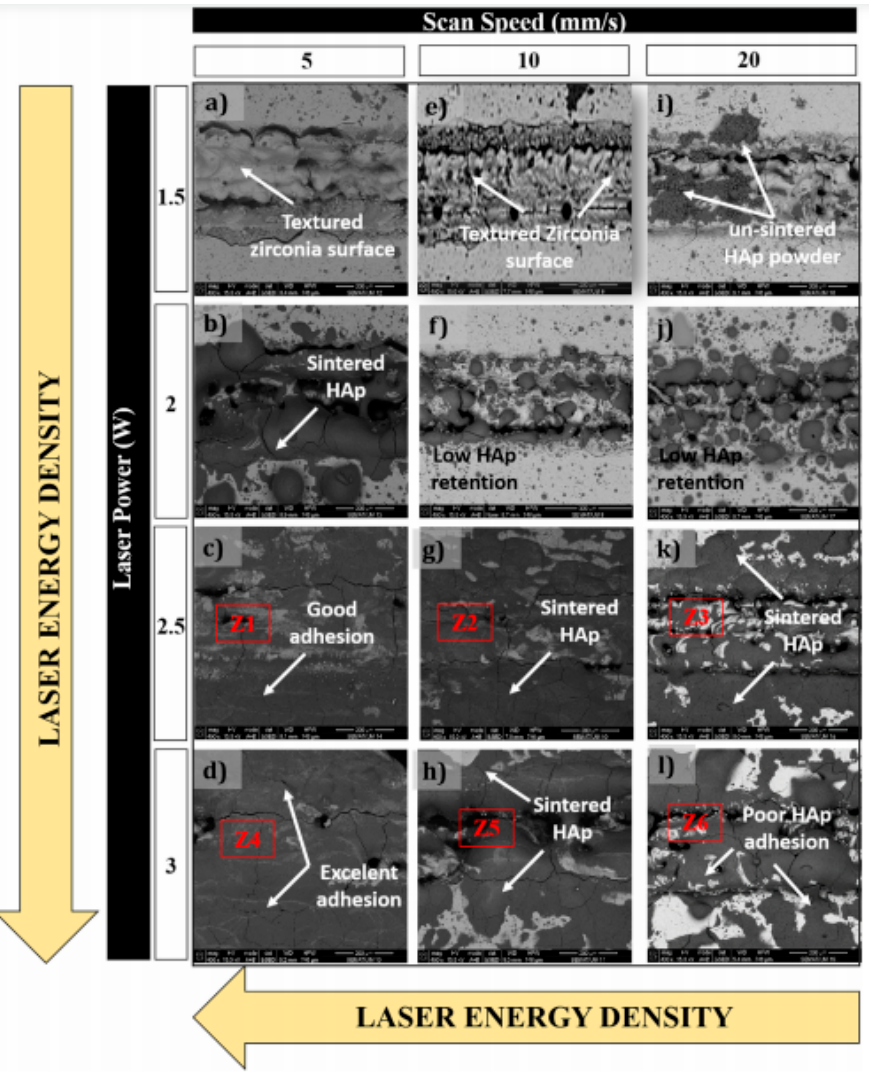
Figure 7. SEM images of the hydroxyapatite (HAp) sintered within the textured at various laser power and scan speeds [75]. Reprinted from [75]. Copyright from Elsevier 2018.